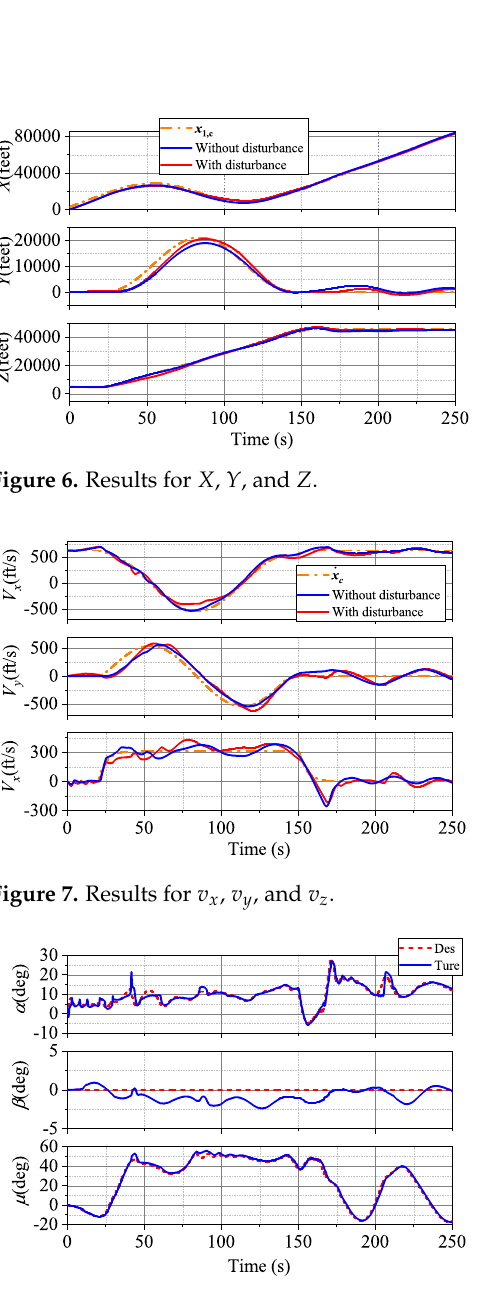
Figure 8. Results for α , β , and µ in presence of disturbances.